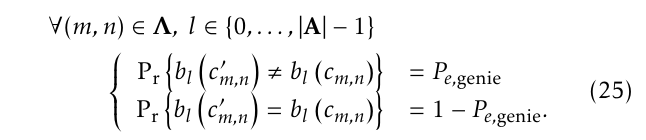
b /N 0 usinga rate 1 / 2 LDPC